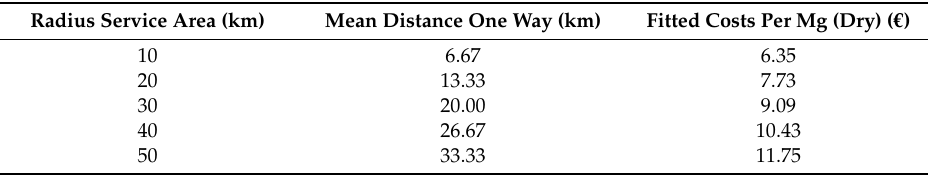
Figure 3. Linear model with 2nd degree polynomic function (red line) modelling the relationship between transport distance and cost per dry Mg of woody biomass. Data points are the black dots. Table 4. Fitted tariff for varying service area sizes.